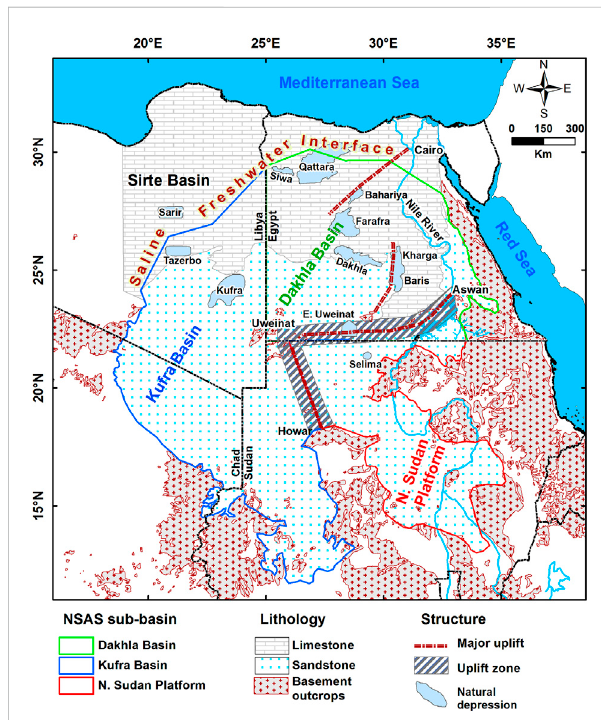
FIGURE 1 Location map showing the distribution of the NSAS, sub-basins, and basement uplifts within the